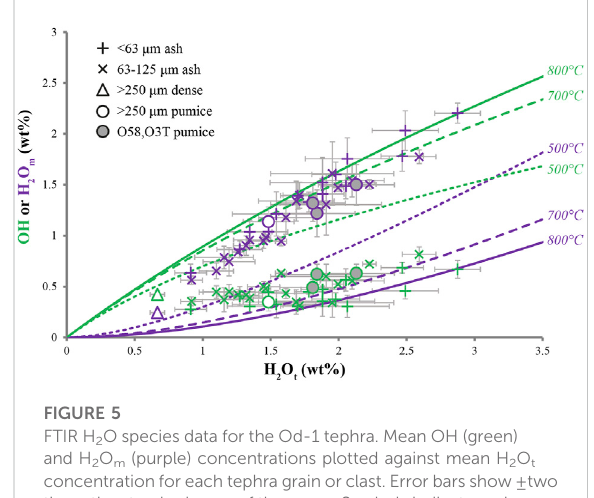
FIGURE 5 FTIR H 2 O species data for the Od-1 tephra. Mean OH (green) and H 2 O m (purple) concentrations plotted against mean H 2 O t concentration for each tephra grain or clast. Error bars show ±two times the standard error of the mean. Symbols indicate grain size fraction. Grey symbols are data for subaerial pumice clasts in the subaerial O58 and O3T deposits reported in McIntosh et al. (2022). Curves show expected OH (green) and H 2 O m (purple) concentrations for a given H 2 O t concentration assuming equilibrium speciation for temperatures of 800 ° C (solid line), 700 ° C (dashed line) and 500 ° C (dotted line). Curves calculated using the H 2 O speciation model of Nowak and Behrens (2001) for rhyolite. Measured species concentrations do not lie on these equilibrium curves, indicating disequilibrium